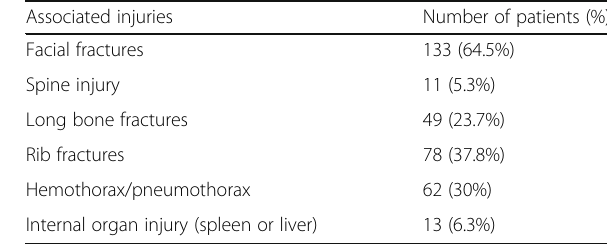
Table 3 Associated body injuries